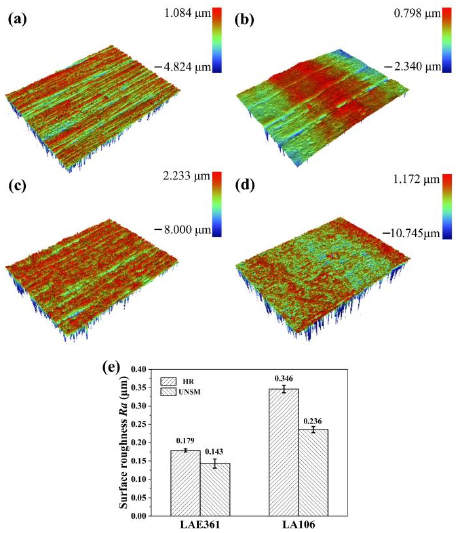
Figure 4. Three-dimensional morphology of LAE361 Mg-Li alloy ( a , b ) and LA106 Mg-Li alloy ( c , d ) and responding surface roughness (Ra) ( e ) before and after the UNSM